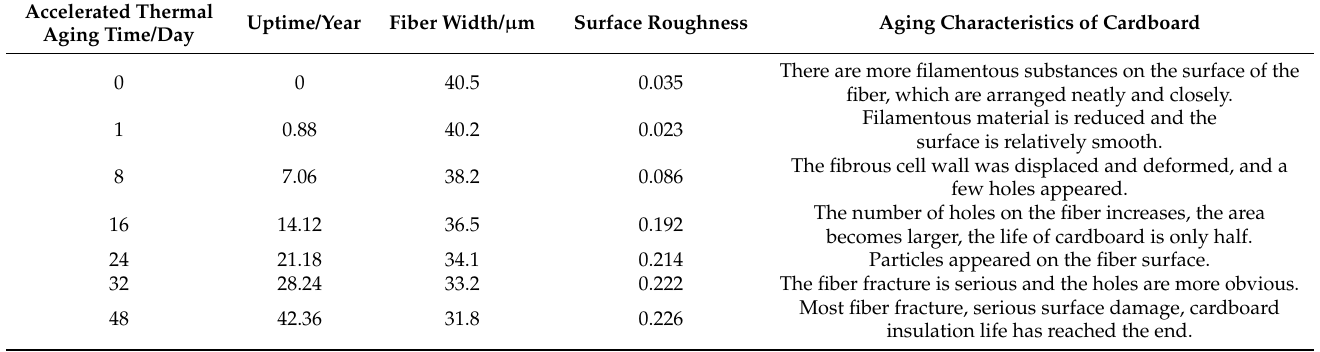
Table 2. Variation of pressboard surface during different accelerated thermal aging